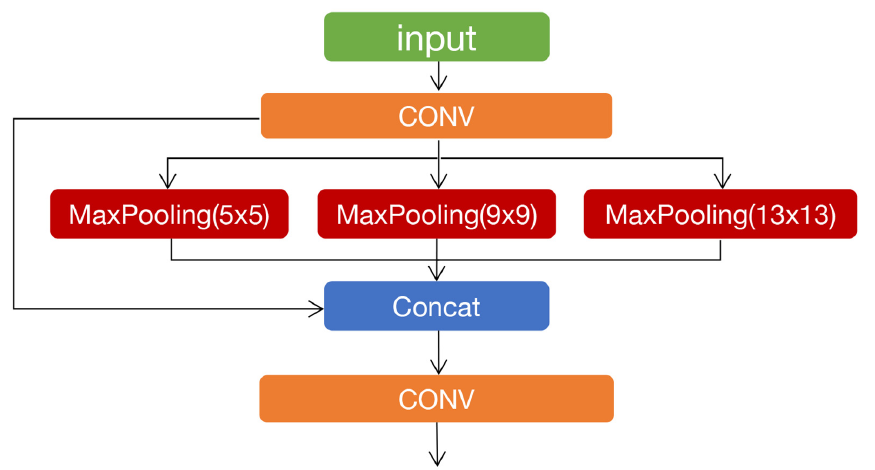
Figure 5. Spatial pyramid pooling